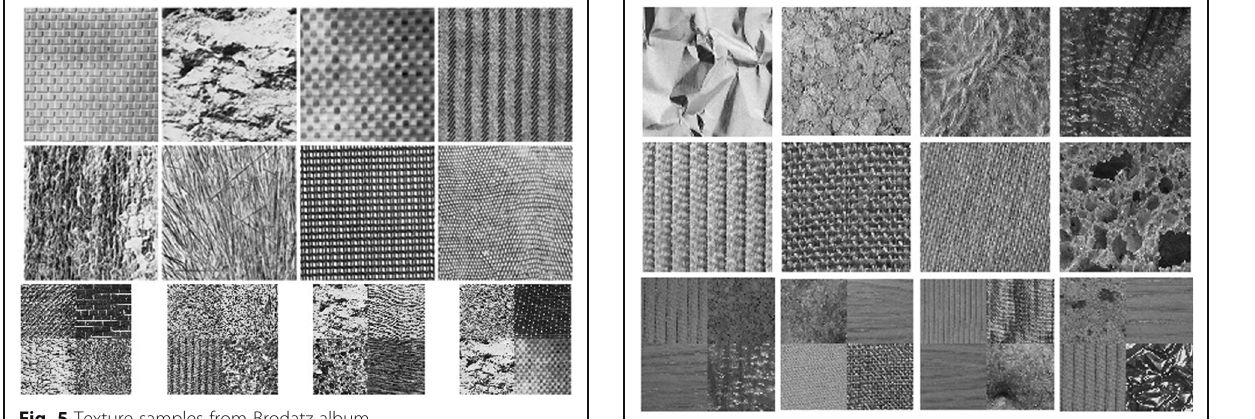
Fig. 7 Texture samples from the KTH-TIPS2 database